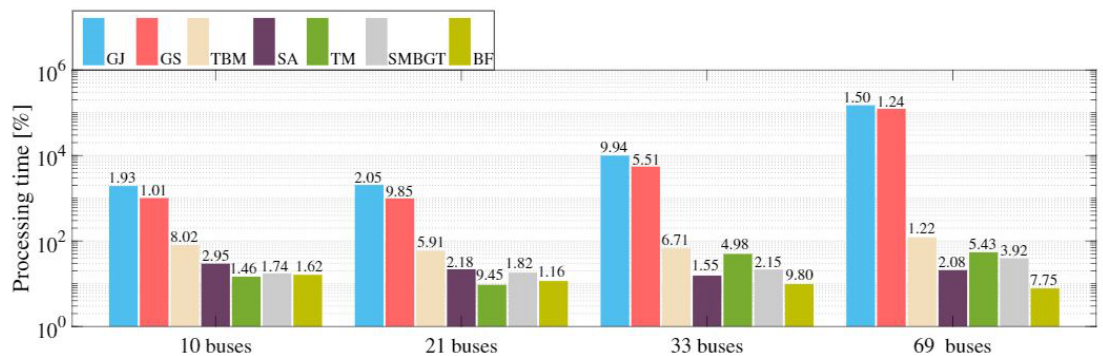
Figure 7. Processing time required for the solution methods with respect to NR in radial test